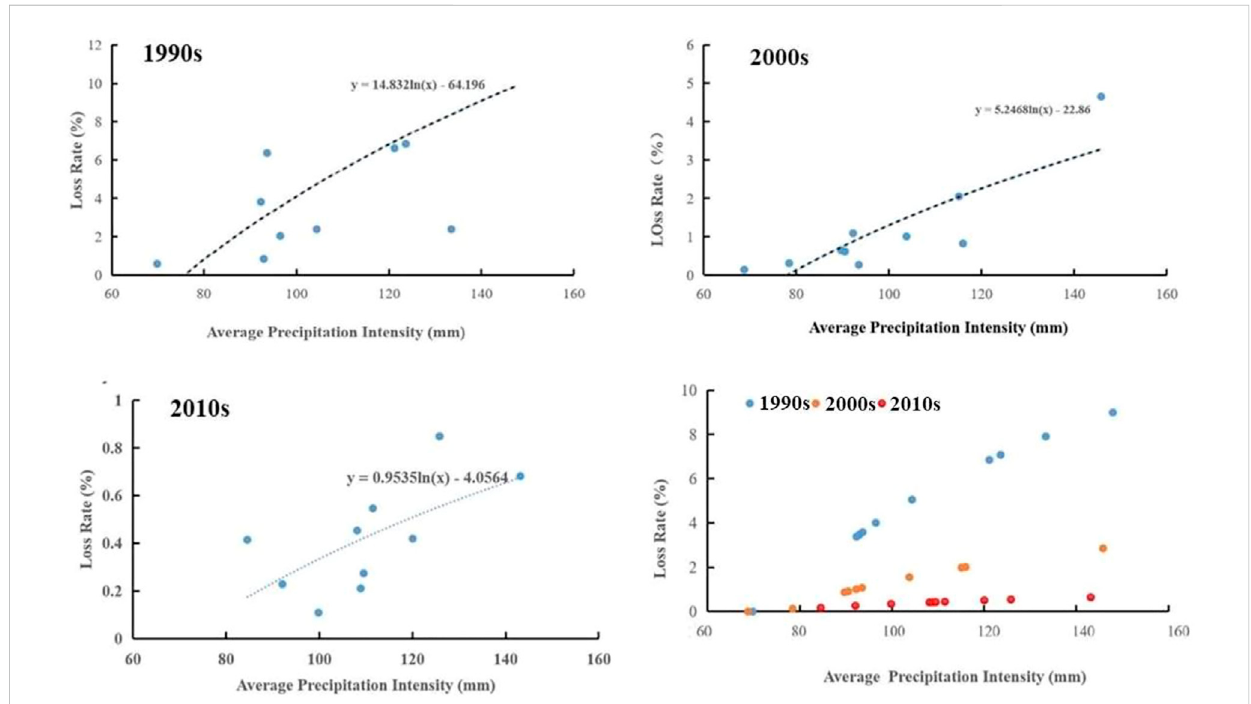
Relationship between extreme precipitation intensity and economic losses per unit area for each decade in the Poyang Lake Basin,